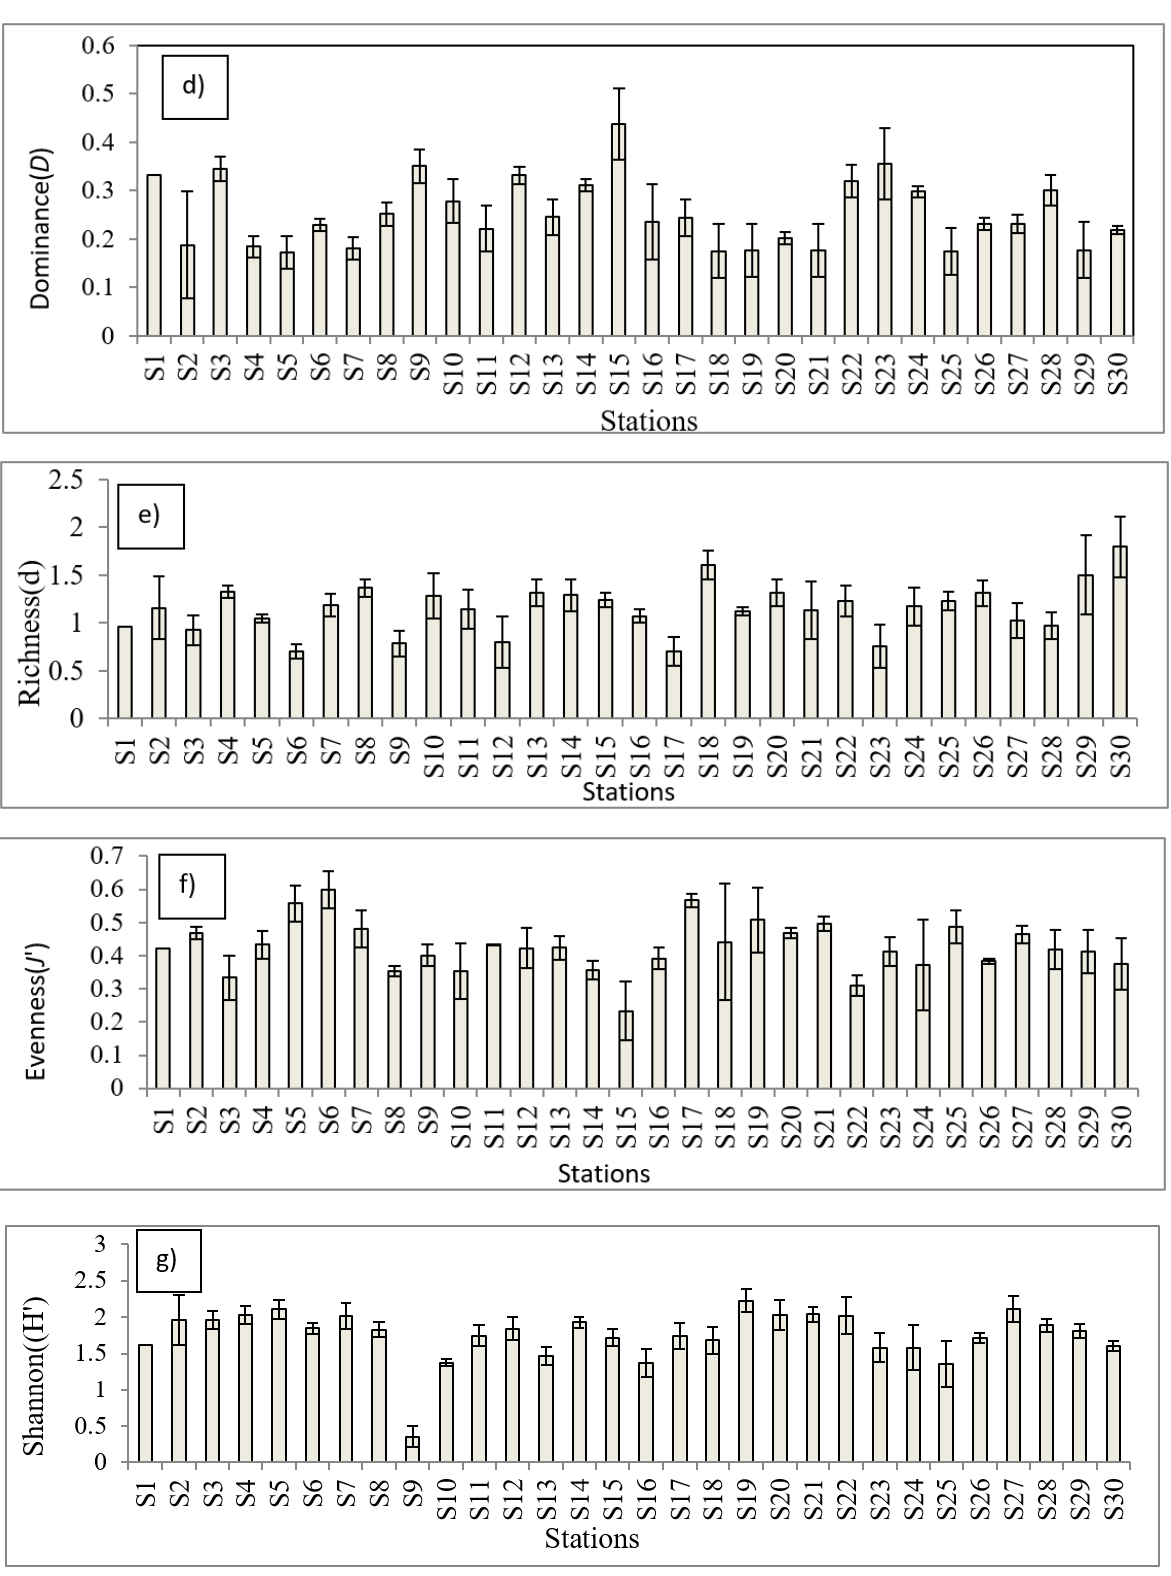
Figure 3. Abundance and diversity indices of algal communities: ( a ) Total mean abundance of algae, ( b ) the abundance of dominant genera, ( c ) the abundance of harmful dominant algal genera, ( d ) dominance index (D) of algae at different stations, ( e ) species richness of algae, ( f ) species evenness (J (cid:48) ) of algae, and ( g ) Shannon–Wiener diversity index (H (cid:48) ) of algae at different